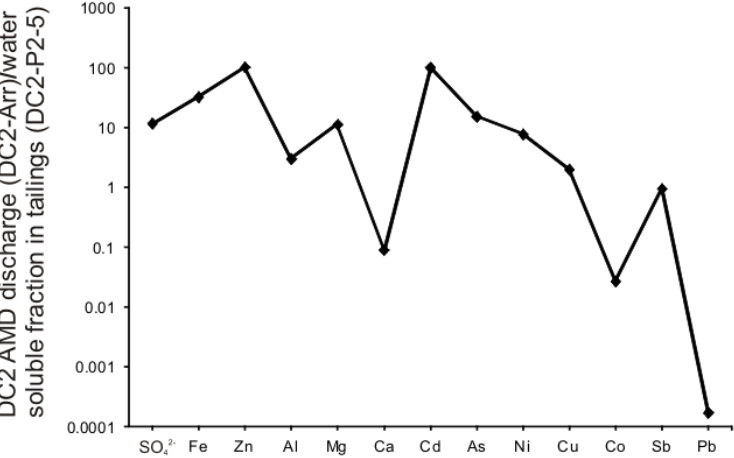
Figure 11. Comparison between the concentration of elements in the water that discharge from the base of DC2 (sample DC2-Arr) and the water-soluble phases in the primary zone from DC2 (sample DC2-P2-5). Concentrations below one for Ca, Co and Pb indicate that they are sequestered in the solid